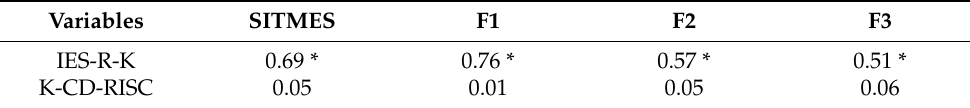
Table 4. Correlation between SITMES and other measures for criterion